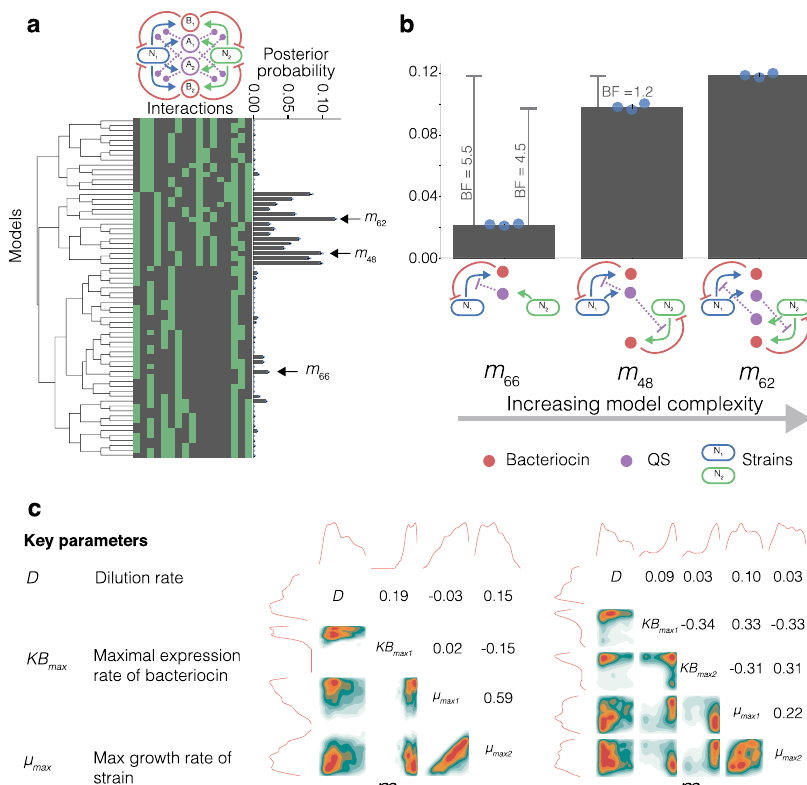
Fig. 2 Output of AutoCD for the two-strain stable steady state objective. a Dendrogram generated by hierarchical clustering of the adjacency matrices for each model in the two-strain model space. All possible interactions are shown in the network illustration. Each column of the heatmap represents a possible interaction between state variables, where green indicates the interaction exists for the model and black indicates absence of the interaction. The bar chart shows the mean posterior probability of each model. The scatter points indicate the posterior probability of each replicate and the error bars indicate the standard deviation. n = 3, where each replicate consists of 180,000 accepted particles. b Shows the mean posterior probability of three models with the highest posterior probability when subsetted for number of parts expressed in order of increasing complexity (2, 3 and 4 parts). The scatter points indicate the posterior probability of each replicate and the error bars indicate the standard deviation. n = 3, where each replicate consists of 180,000 accepted particles. Bayes factors (BF) are shown for pairwise comparison of the three models. Model schematics show the interactions between strains (blue and green), bacteriocin (red) and QS molecules (purple). c Posterior parameter distributions of several tunable parameters in m 66 and m 62 . The top and left plots show 1D density distributions of each parameter, central distributions are 2D density distributions for each pair of parameters. Pearson correlation coef fi cients are shown on the top side of the diagonal for each parameter pair.